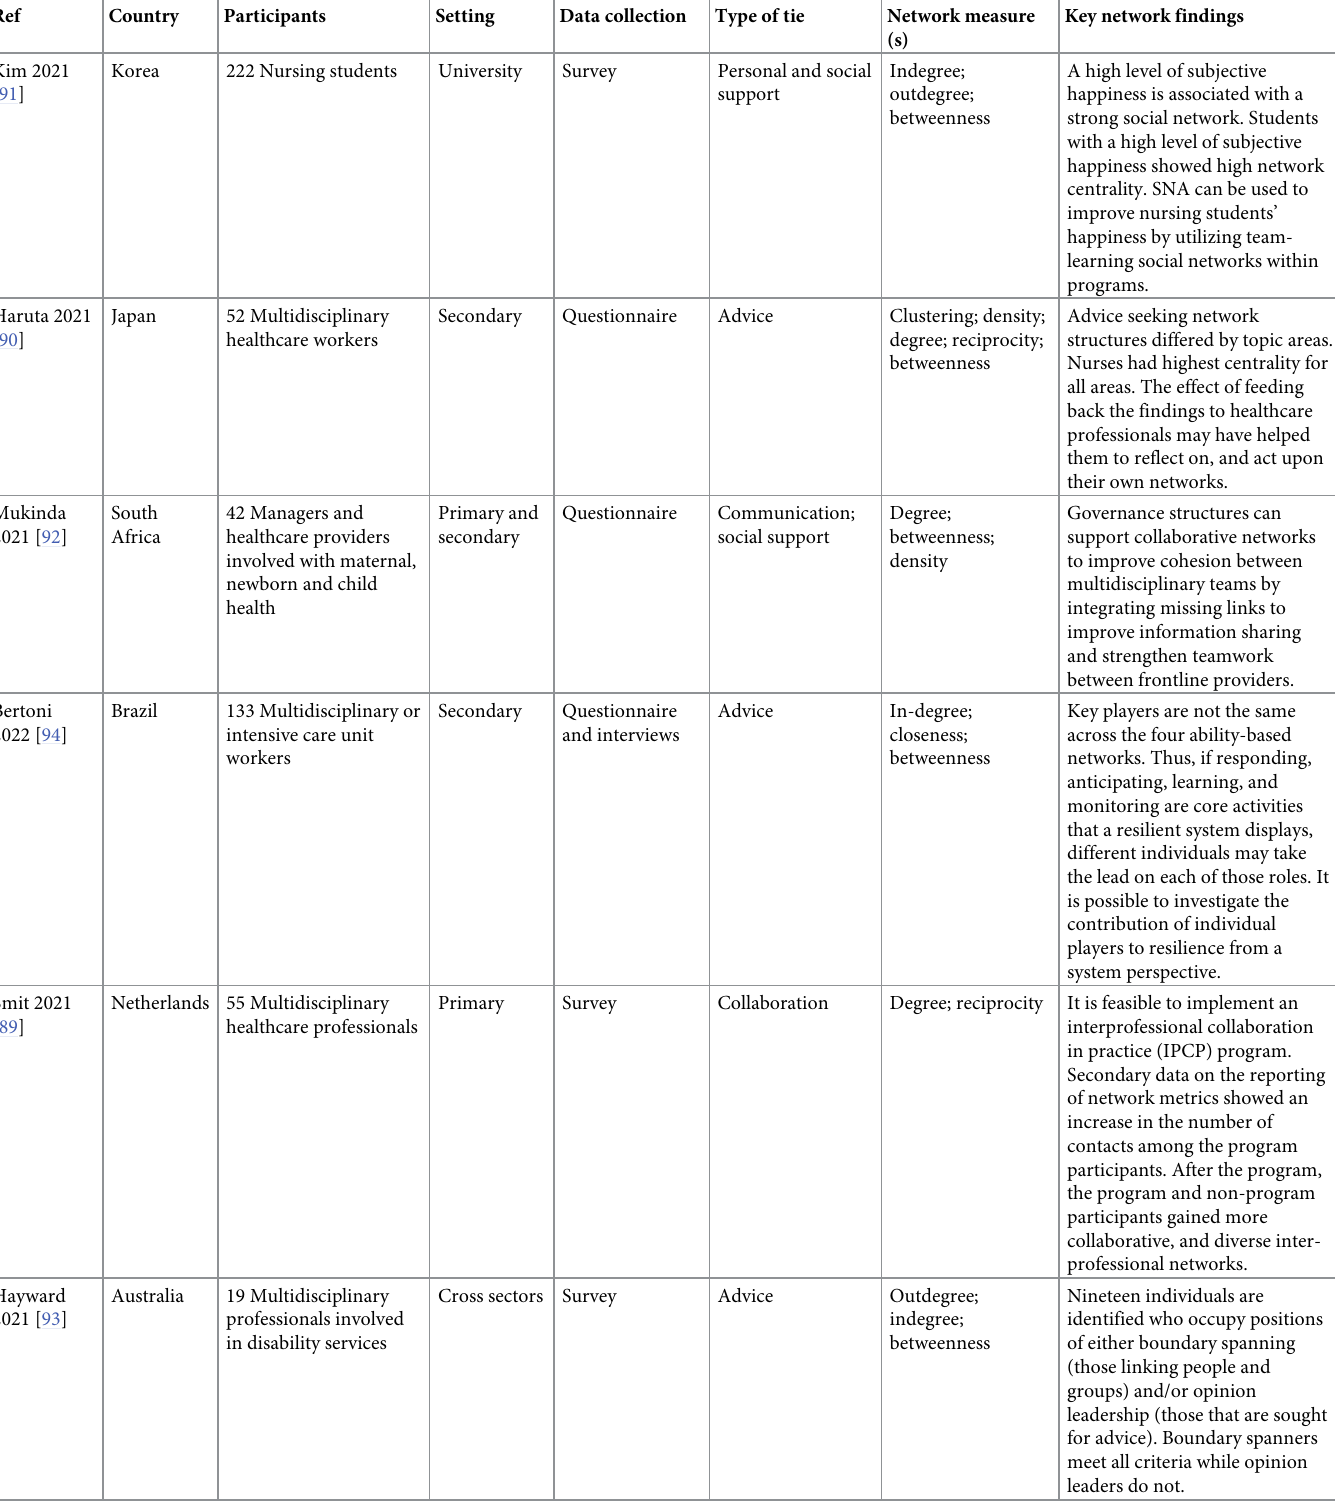
Table 2. The level-2